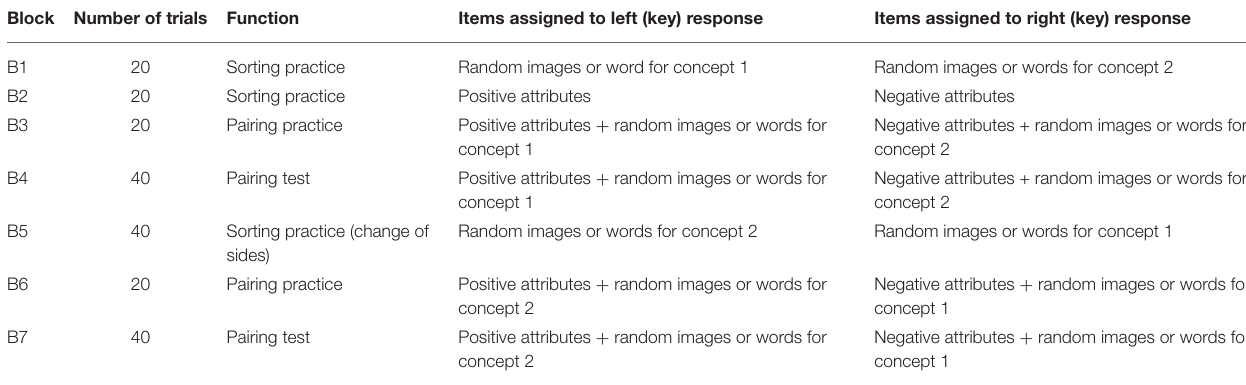
TABLE 1 | Sequence of trial blocks for assessing two subjects (e.g., overweight vs. lean individuals as concepts 1 and 2). Block Number of trials